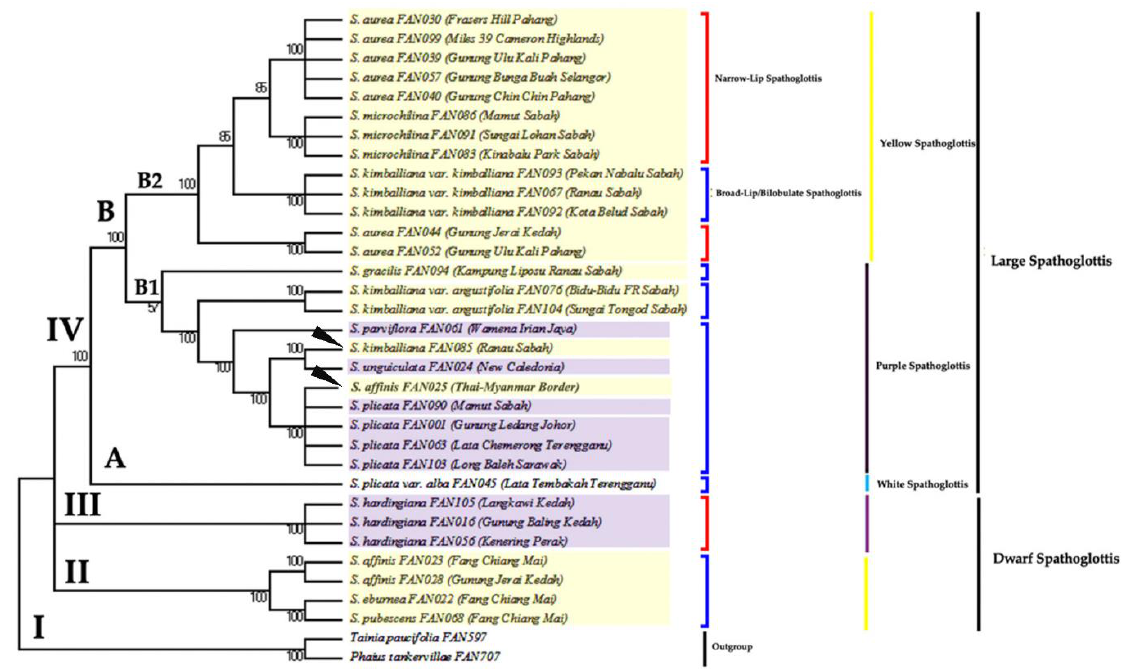
Figure 3. The consensus tree inferred from seven equally parsimonious trees via MP analysis of genus Spathoglottis based on ITS sequence. Number below branches are bootstrap percentages ≥ 50. Branches corresponding to partitions reproduced in less than 50% trees are collapsed. Tree length = 346; consistency index, CI = 0.712; retention index, RI = 0.909; and composite index, RC = 0.699 (RC = 0.647) for all sites and parsimony-informative sites (in parentheses). Clade II-IV shows the ingroups of genus Spathoglottis ; Clade I indicates outgroup. Clade II and III holds the Dwarf Spathoglottis species, while Clade IV (A and B) consists of the Large Spathoglottis species. Clade B is further separated into subclades B1 and B2; each holds the Large Purple and Large Yellow Spathoglottis species group, respectively.